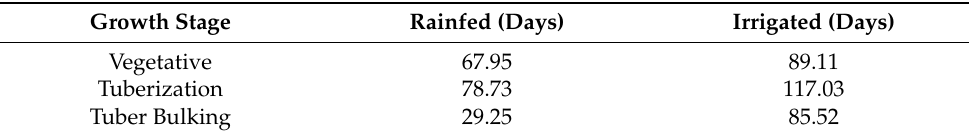
Table 2. Leaf area duration days in Rainfed and Irrigated, classified by growth